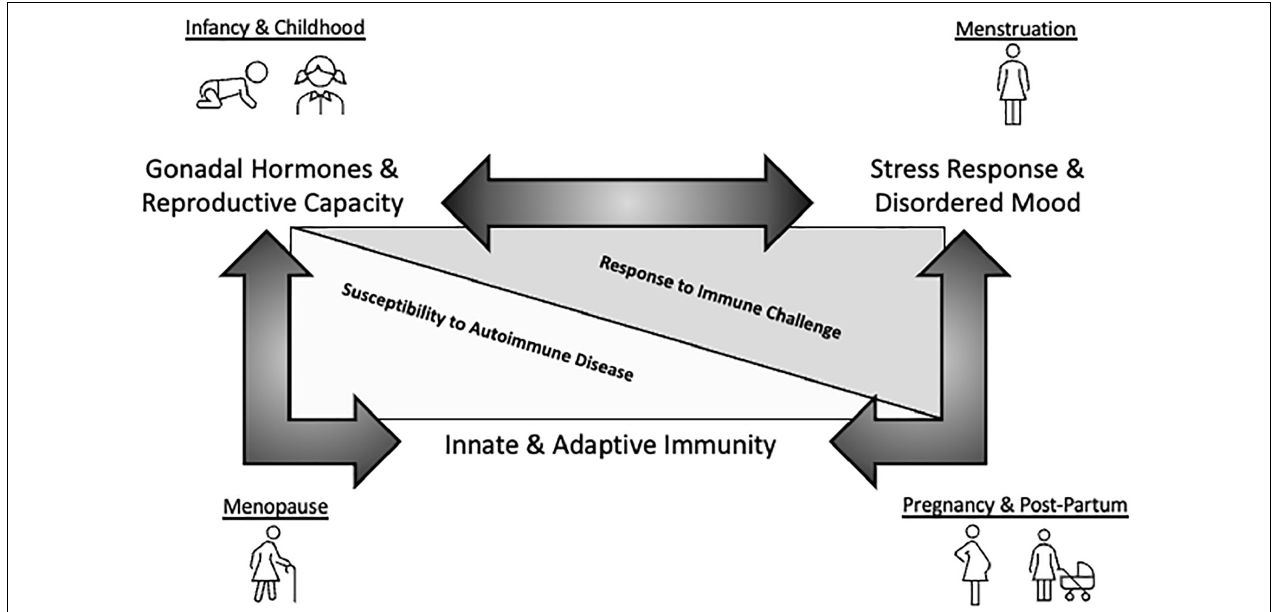
FIGURE 2 | Schematic representation of mood-immune convergence across the female reproductive lifespan. A substantial amount of research has been dedicated to exploring how endocrine and immune factors impact mood separately. For instance, neuroprotective effects of estrogen in regards to MDD are well-established. Further, inflammatory insult and immune dysfunction are emerging as key contributors to disordered mood. Finally, genetic sex and estrogen clearly modulate immune system components, having important functional consequences for immunity across the reproductive lifespan. However, insight regarding how these two systems converge to impact mental health, especially during aging, is currently limited. This knowledge gap may be driven by experimental challenges associated with exploring these complicated interactions including, but not limited to, heterogeneity associated with the study population and sample size, the species used, the stressor nature and severity being evaluated, the approach to measure cytokine levels, the post-stress measurement timeframe, to name a few examples. Whether estrogenic influences on inflammatory activation cascades in the context of ‘sterile’ psychosocial stress-induced immune challenges result in sex-specific susceptibility to MDD during key reproductive milestones remains to be further interrogated and represents an exciting area of